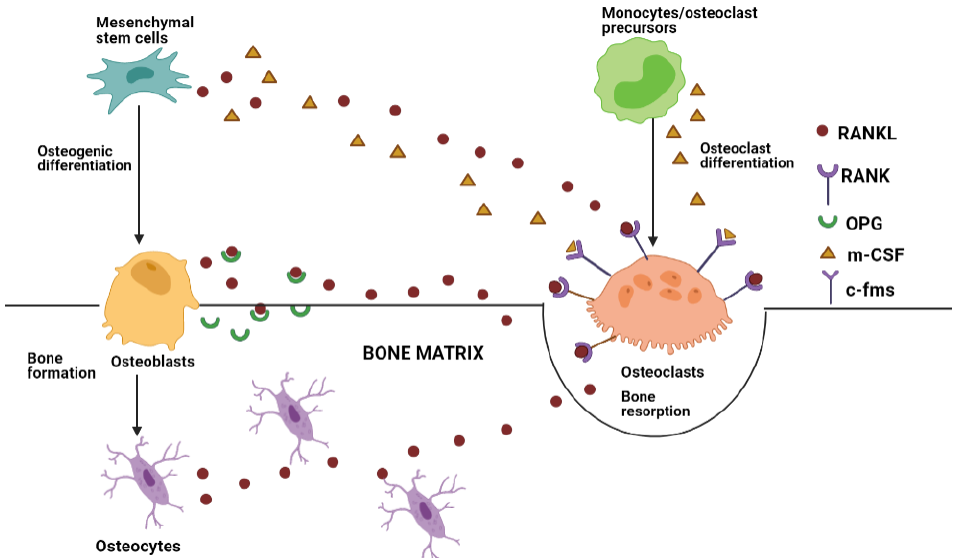
Figure 1. Schematic representation of role of RANKL/RANK/OPG signaling in Bone homeostasis. Bone formation initiates with osteogenic differentiation of mesenchymal stem cells into osteoblasts. A sub population of these osteoblasts are terminally differentiated into osteocytes, which embed inside the bone matrix. Specific matrix sensing by the osteocytes triggers recruitment of osteoclast precursors (monocytes/macrophages), which differentiate into osteoclasts. During early osteoclast differentiation, MSCs and the precursor cells secrete M-CSF, which binds to c-fms receptor on the osteoclasts. This process is also coupled with release of RANKL from MSCs, osteoblasts, and osteocytes, which binds to RANK receptor on osteoclasts. Additionally, osteoblasts also secrete OPG inhibitor for competitive inhibition of RANKL to counter the bone resorption process.